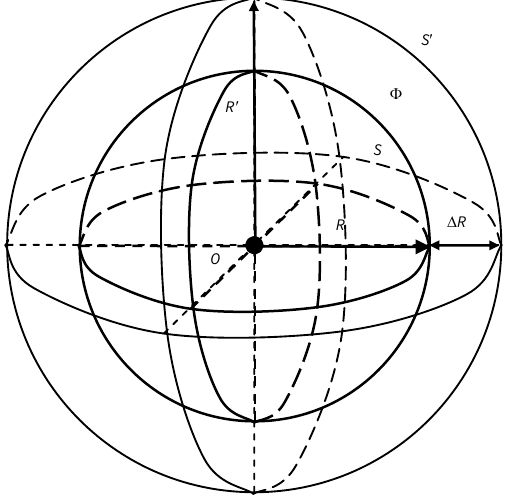
Figure 7. Sphere shell surface subdivision of face 0